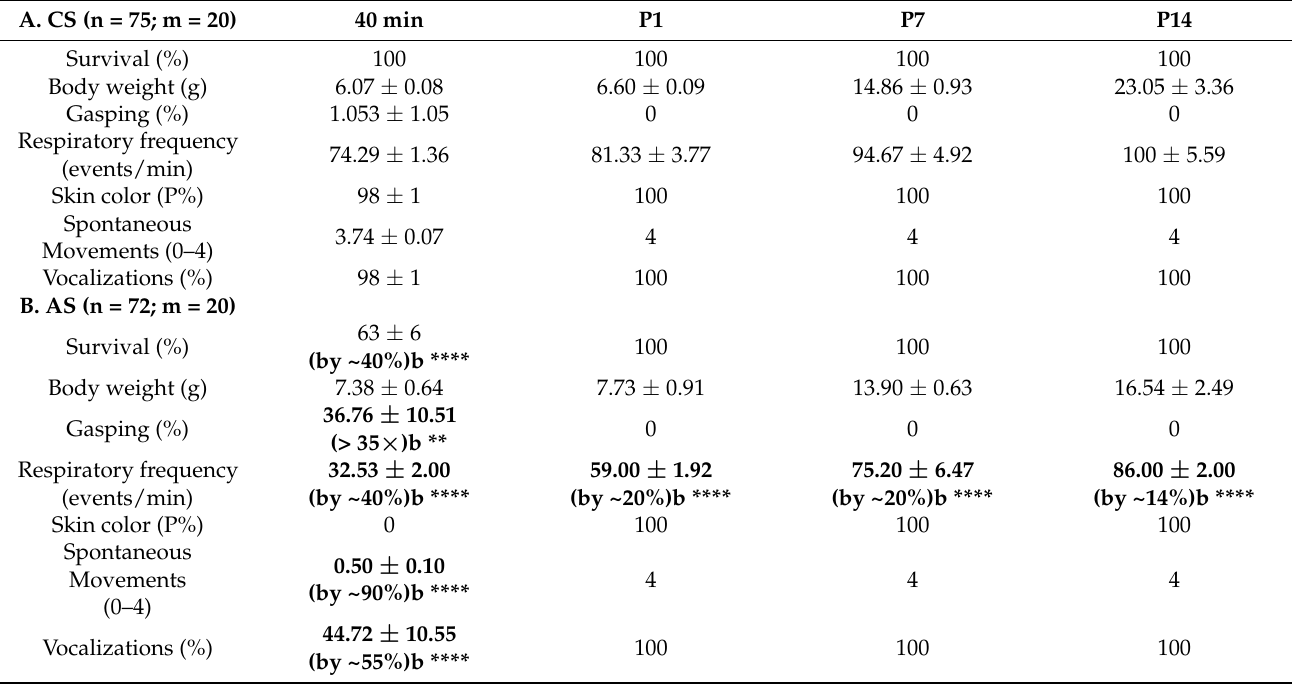
Table 1. Apgar and postnatal evaluation. The data are expressed as means ± SEM, from control (n = 75) and asphyxia-exposed rat neonates (n = 72). Whenever the parameters were monitored by continuous scales, or by % of the corresponding litter in cases of qualitative no continuous scales (n, number of pups; m, number of dams). The effect of neonatal development ( A ) and perinatal asphyxia (PA) ( B ) was evaluated on (i) survival (F(1, 45) = 7.701, p < 0.0001); (ii) body weight (F(6, 322) = 119.283, p < 0.0001); (iii) gasping (yes/no; in % for the corresponding litter) (F(4, 60) = 4.746, p < 0.002); (iv) respiratory frequency (events/min) (F(4, 178) =